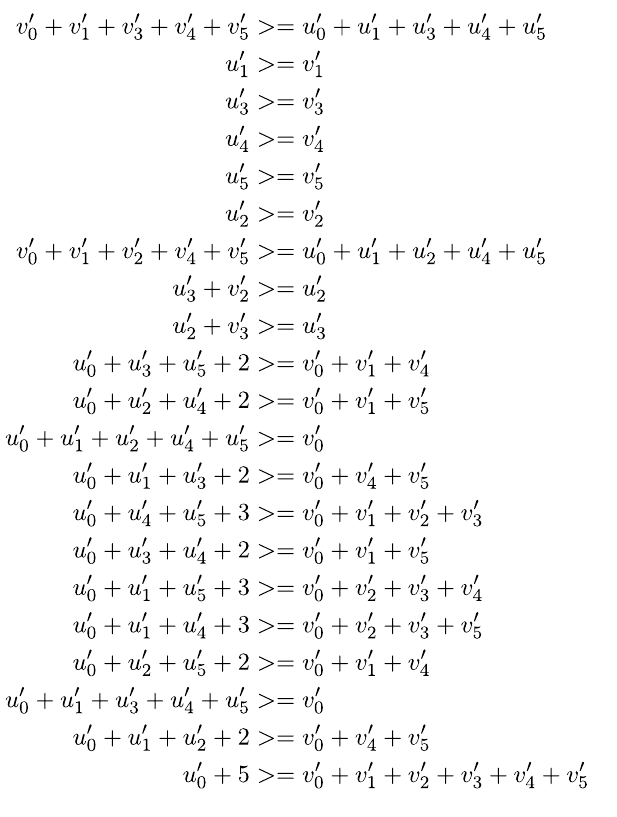
Figure 5. Inequalities for F